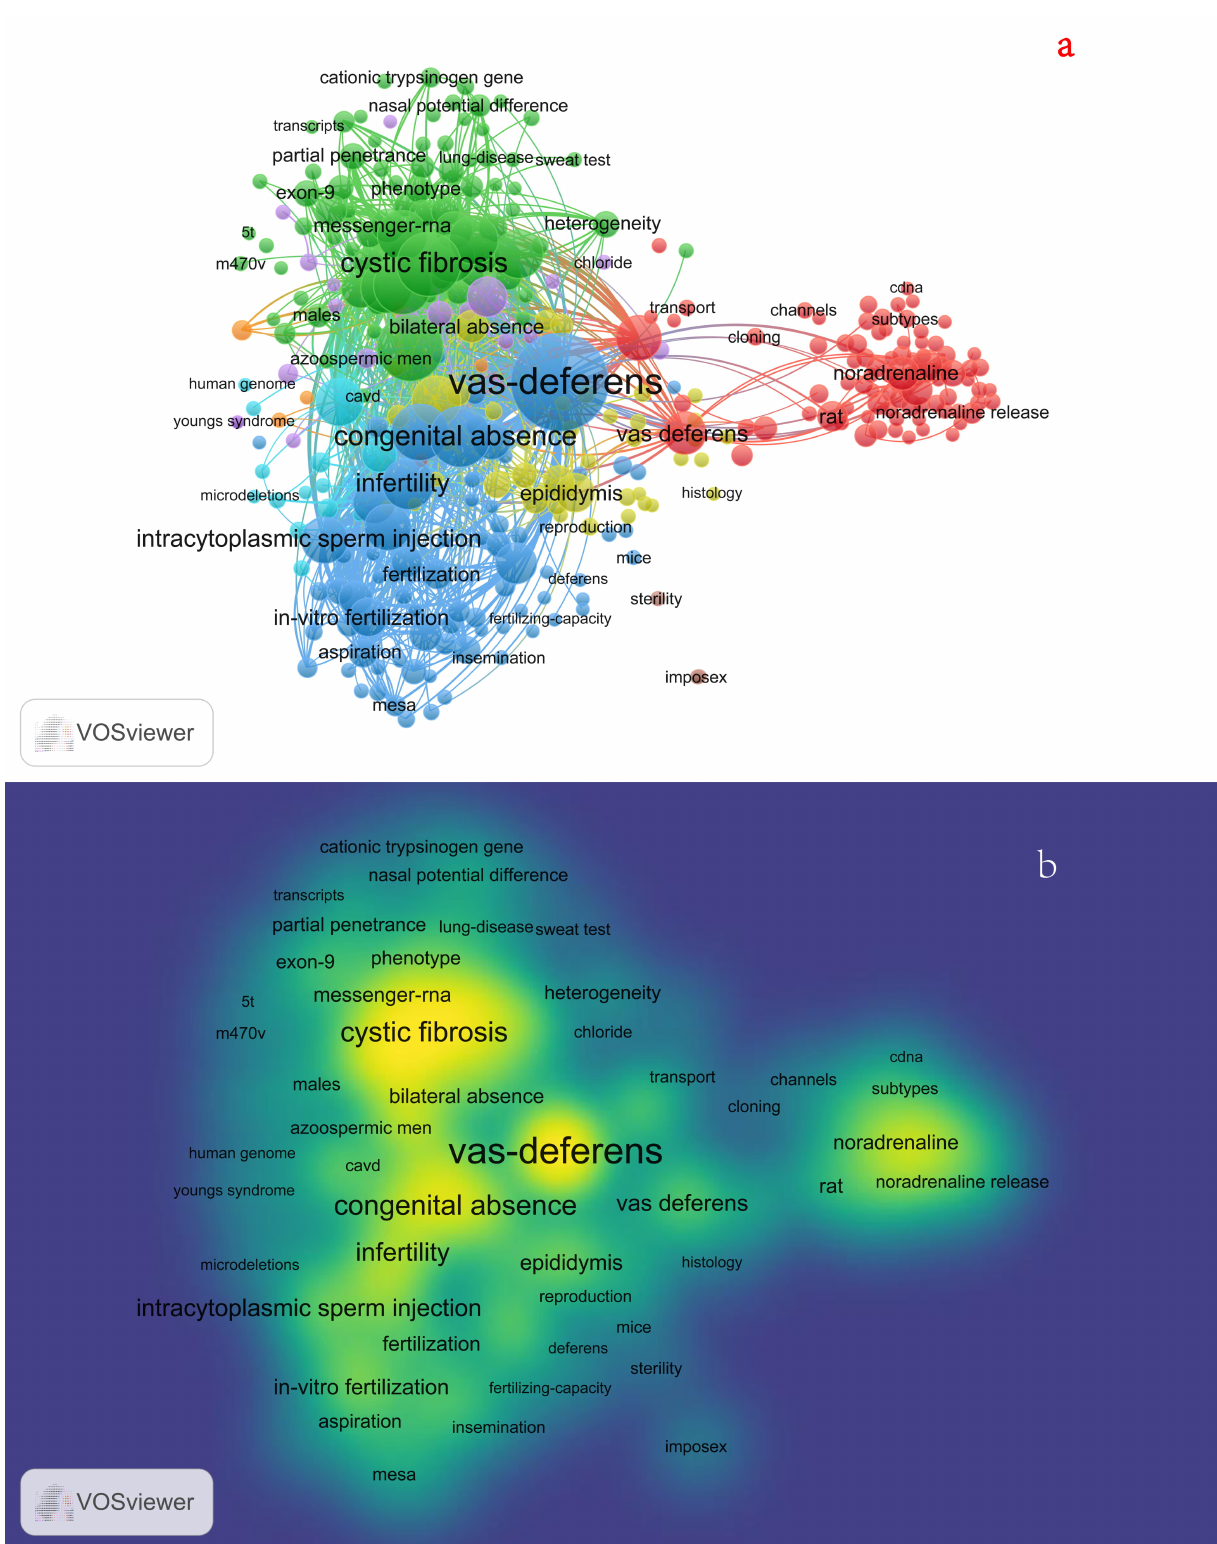
Fig. 7. The font size of each key word’s name represents the number of articles in the institutions. The thickness of the curved connecting line represents the collaborative intensity between key words. (a) The key words collaboration network of AVD research, and the same color represents the same cluster. (b) The brighter the color, the more research about these key